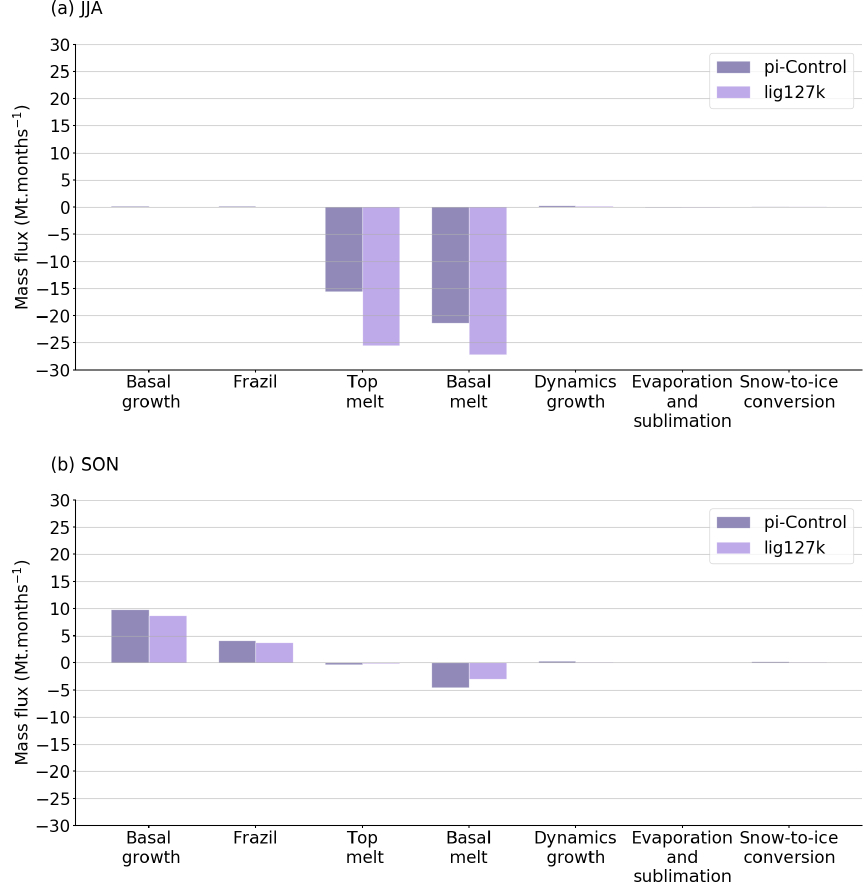
Figure 17. Components of the Arctic sea ice mass budget (Mt per month) in (a) JJA and (b) SON. They are computed for both the PI (dark purple) and LIG (pale purple)